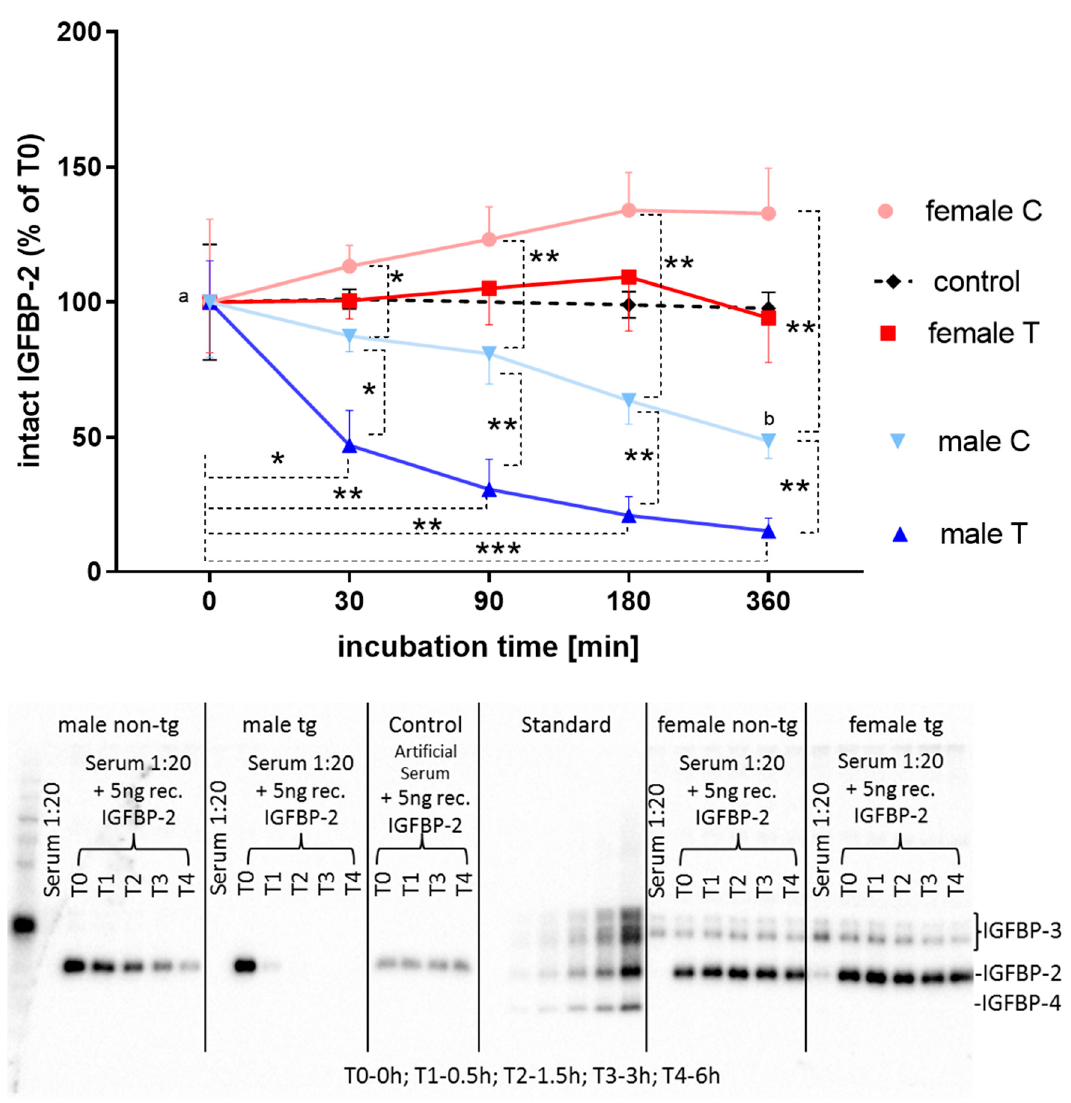
Figure 9. Stability of supplemented intact IGFBP-2 in serum from male (blue) and female (red) IGFBP-2 transgenic mice (T) and non-transgenic (C) littermates (DU6P / C57BL / 6) as a function of incubation time at 37 ◦ C. Diluted serum samples were supplemented with 5 ng murine recombinant IGFBP-2 for up to 360 min. The presence of intact IGFBP-2 was assessed by Western ligand blotting as described in Section 2 (mean ± SEM; age: 7 weeks; n > 5; *: p < 0.05; **: p < 0.001; ***: p < 0.001; a versus b: significant reduction of intact IGFBP-2 also in non-transgenic male mice after 360 min). As a negative control, artificial serum matrix was supplemented with 5 ng murine recombinant IGFBP-2 for the indicated durations ( n = 3).